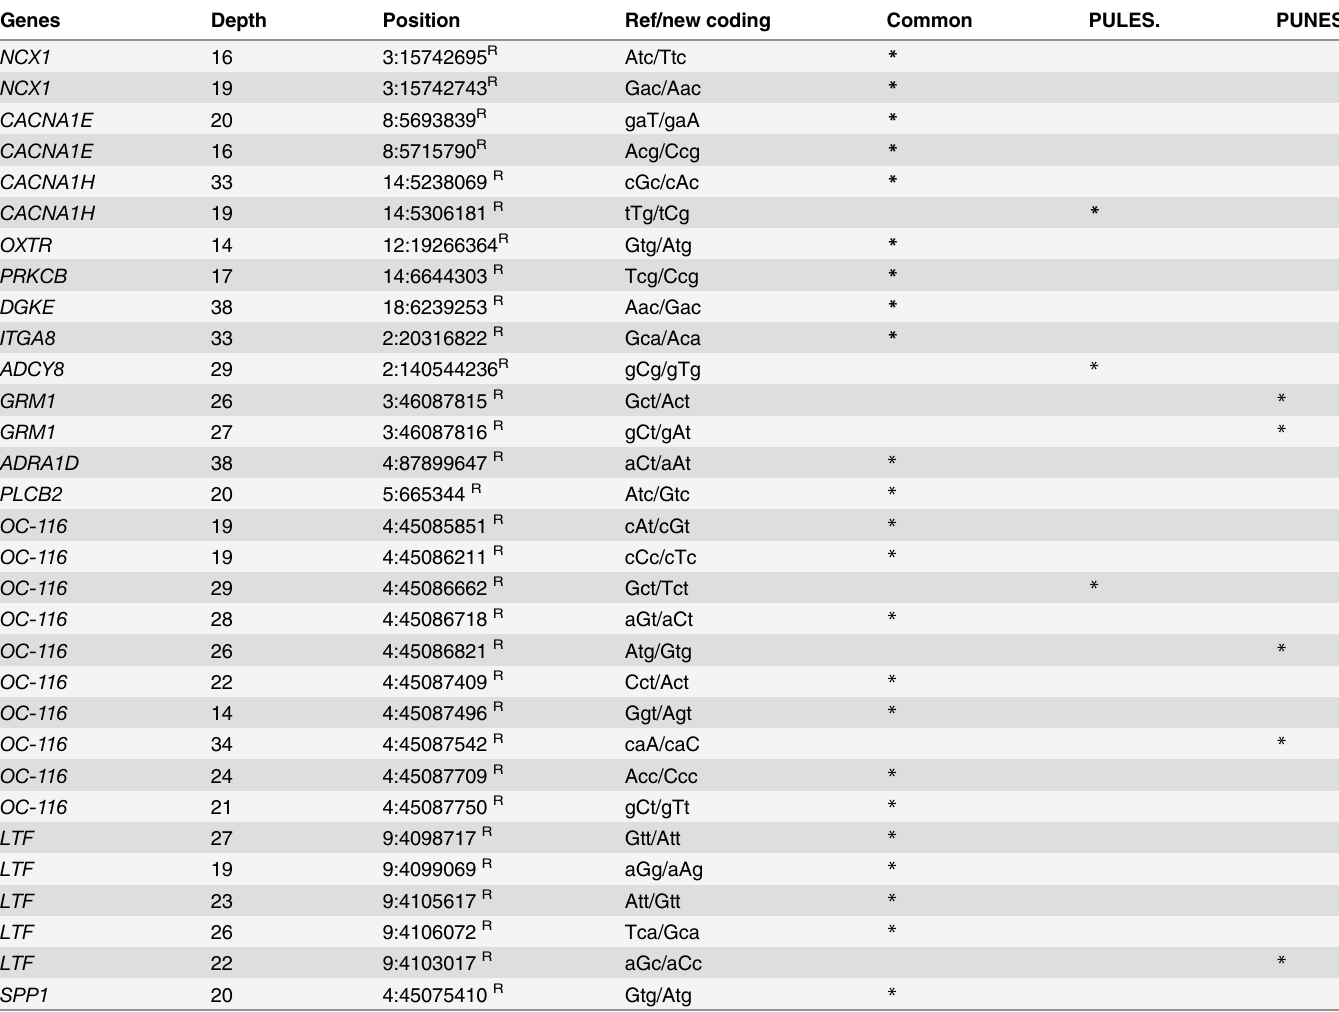
Depth: the number of reads to support the variation. Uppercase letter represent single-nucleotide polymorphism (SNP). R SNP sites were also detected using